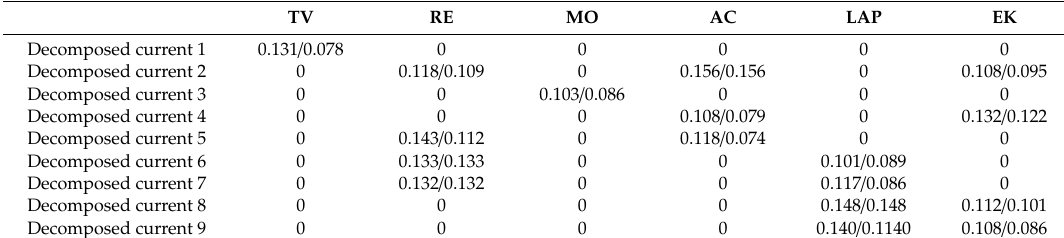
Table 4. Euclidean distance between the decomposed current and 5 known samples.